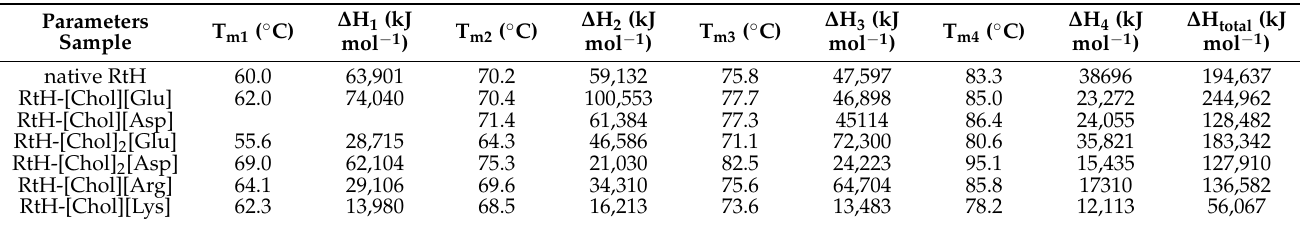
Table 3. The thermodynamic parameters for the thermal denaturation of RtH in presence of [Chol] n [AA] determined after a successive annealing procedure.